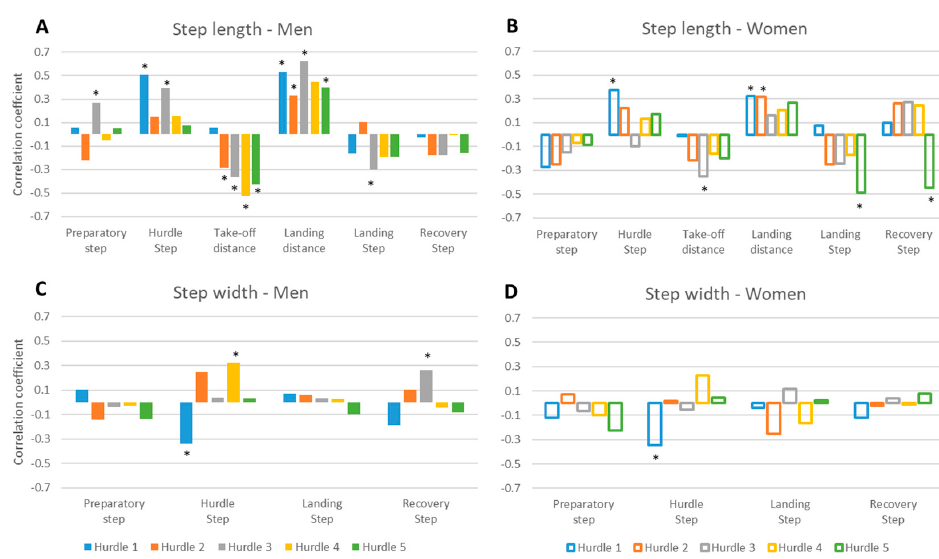
Figure 5. Pearson’s correlation coefficient (r) between spatial parameters (( A , B ) step length; and ( C , D ) step width) and the hurdle-unit split times during the 44th Spanish Indoor and 12th IAAF World Indoor Championships. Correlations: * p < 0.05.